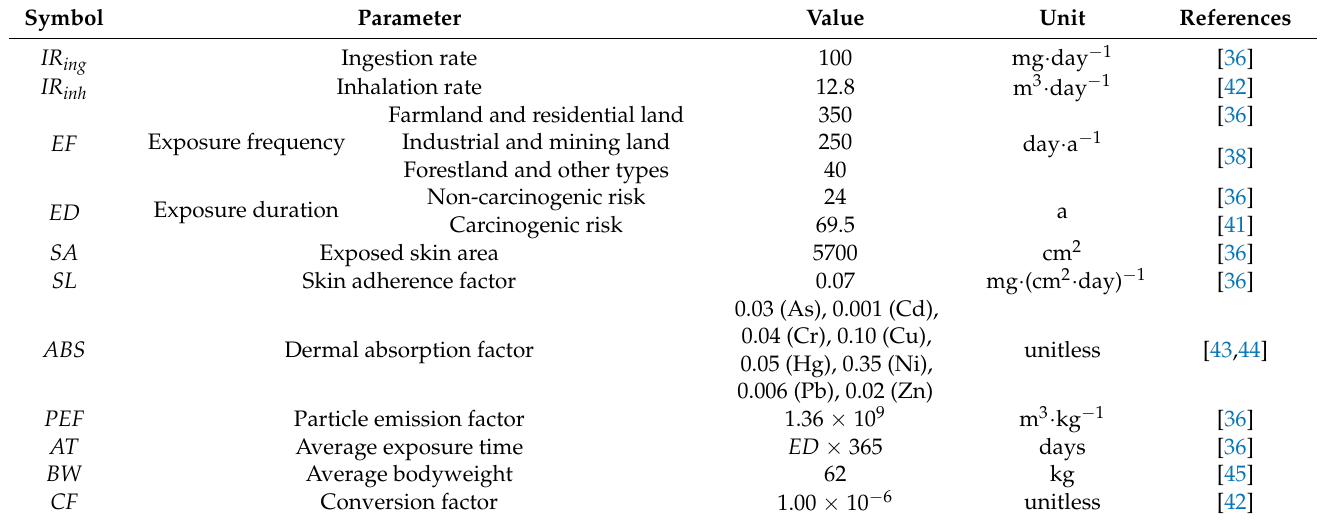
Table 2. Exposure parameters used to characterize the chronic daily intake ( CDI ) of heavy metals.